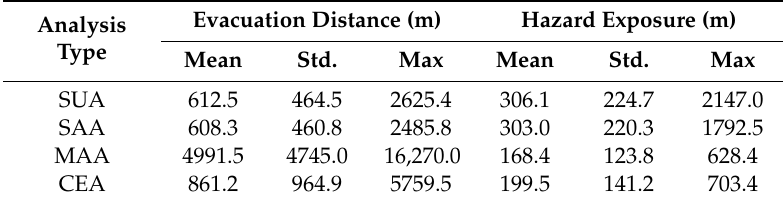
Table 3. Summary of results of evacuation route analysis.